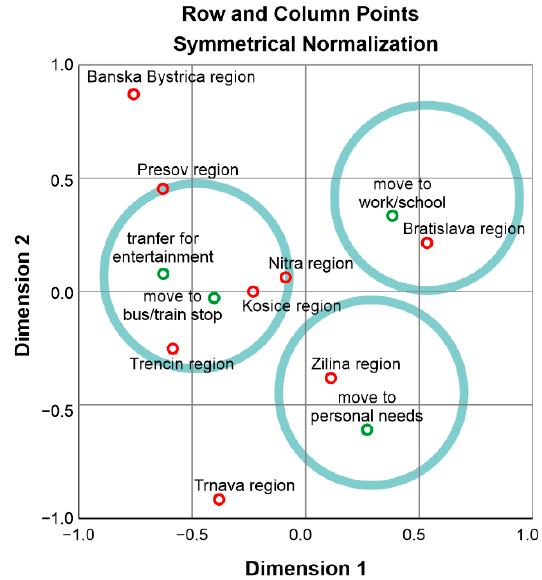
Figure 4. Correspondence map I.